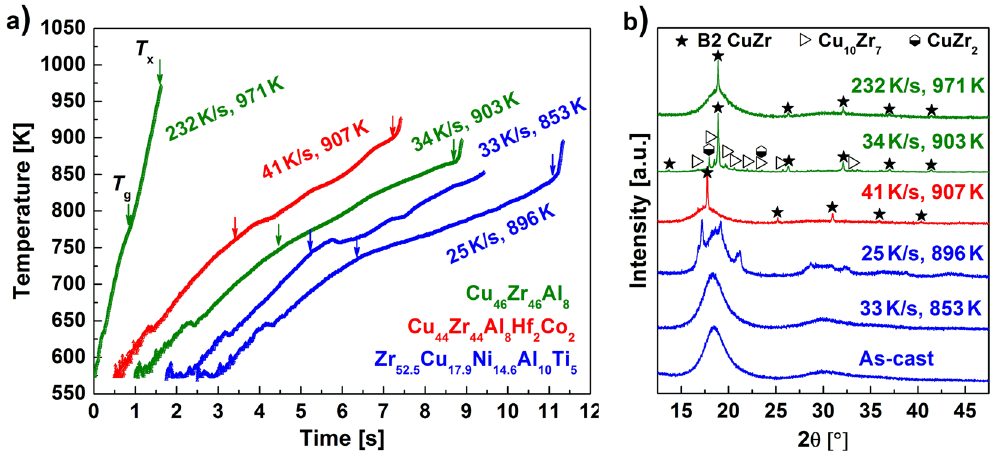
Figure 4. Characteristics of BMG specimens during flash-annealing. ( a ) Heating curves of Cu 46 Zr 46 Al 8 , Cu 44 Zr 44 Al 8 Hf 2 Co 2 and Zr 52.5 Cu 17.9 Ni 14.6 Al 10 Ti 5 BMG specimens flash-annealed at indicated heating rates and temperatures (below and above T x ). ( b ) XRD patterns of the flash-annealed and as-cast glasses. The patterns of the specimens flash-annealed above T x display sharp reflections originating from crystals. The heating rates, annealing temperatures and crystalline phases are